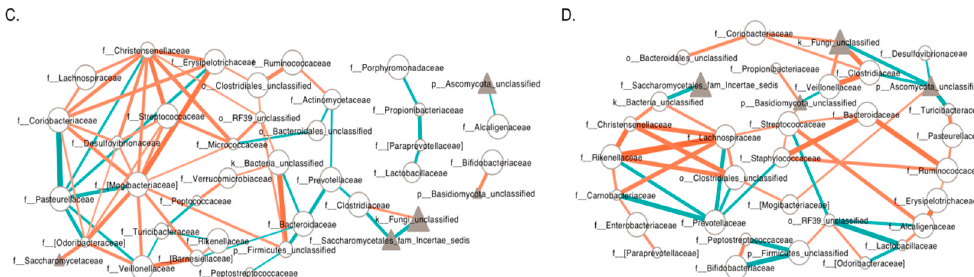
Figure 5. Microbial family (bacterial and fungal) co-occurrence networks for four subgroups. ( A ) Normal weight (NW) controls. ( B ) Overweight or obese (OWOB) controls. ( C ) NW PWS children. ( D ) OWOB PWS children. Taxon pairs with Spearman’s Rho ≥ 0.3 or ≤ − 0.3 with p -values < 0.05 were visualized. Circular nodes represent bacterial families, and triangular nodes represent fungal families. The size of the nodes indicates the occurrence frequency in each subgroup. Green lines indicate negative correlations, and orange lines indicate positive correlations. Connector line thickness represents the value of the Spearman correlation coefficient ( ρ ). Family names on the nodes represent the proposed taxonomy by the Greengenes database.